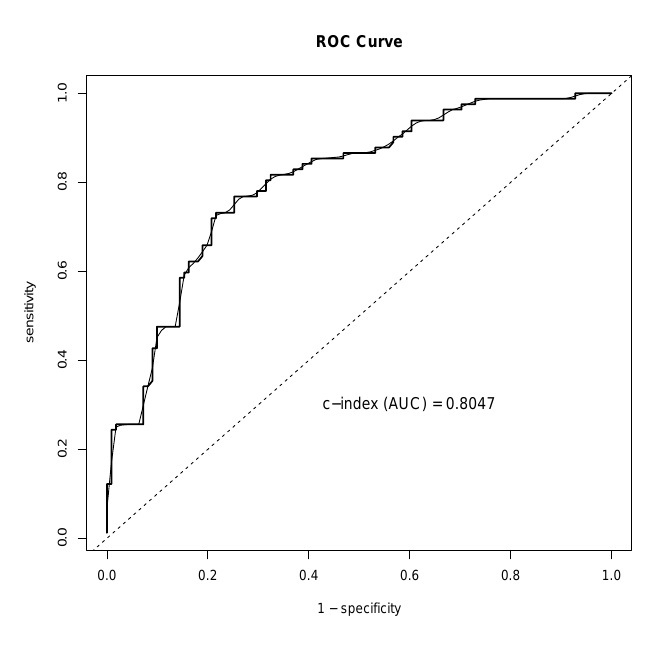
Figure 3 – ROC curve for the fitted logistic regression model